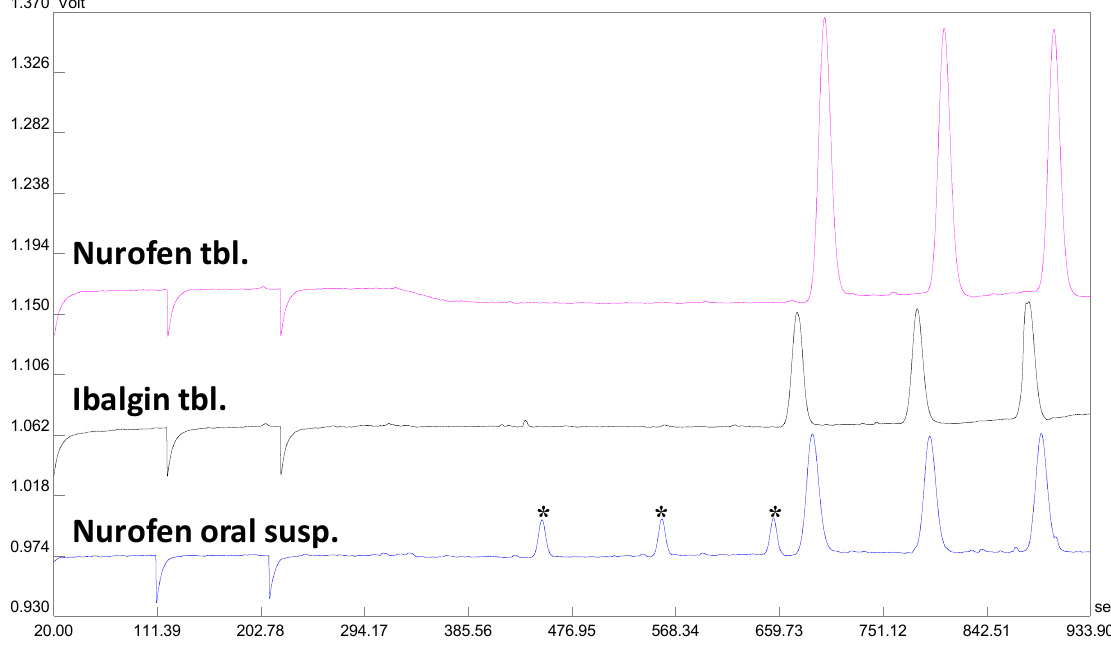
Figure 3. Illustrative electropherograms obtained from the CZE-UV analysis with repeated sample injection of ibuprofen in real pharmaceutical samples—drug Ibalgin (tablets), drug Nurofen (tablets) and drug Nurofen (oral suspension). *—an unidentified component present in the oral suspension sample matrix.